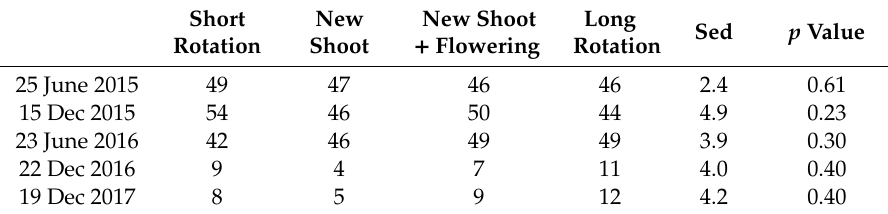
Table 3. Basal cover (%) of SARDI 7 lucerne during the three years of study at Rutherglen, from January 2015 until December 2017. Pre-defoliation treatment basal cover, assessed at December 2014, was used as a covariate in the assessments between June 2015 and June 2016, inclusive. The analyses of the first three assessments had 11 residual degrees of freedom, whilst the final two assessments had 12 residual degrees of freedom.